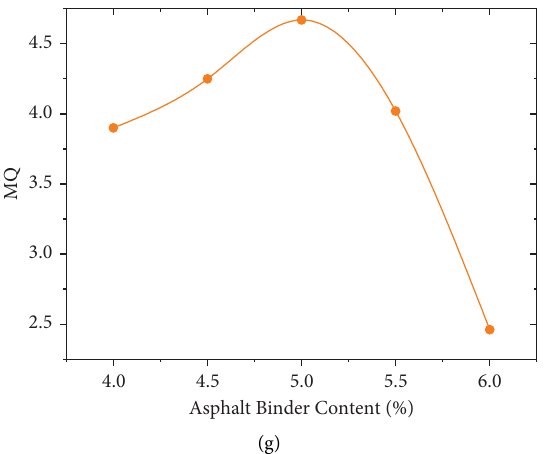
Figure 2: Marshall test results for the conventional asphalt mixture: (a) stability, (b) fow, (c) bulk specifc gravity, (d) voids flled with bitumen, (e) air voids, (f) voids in mineral aggregate, and (g) Marshall